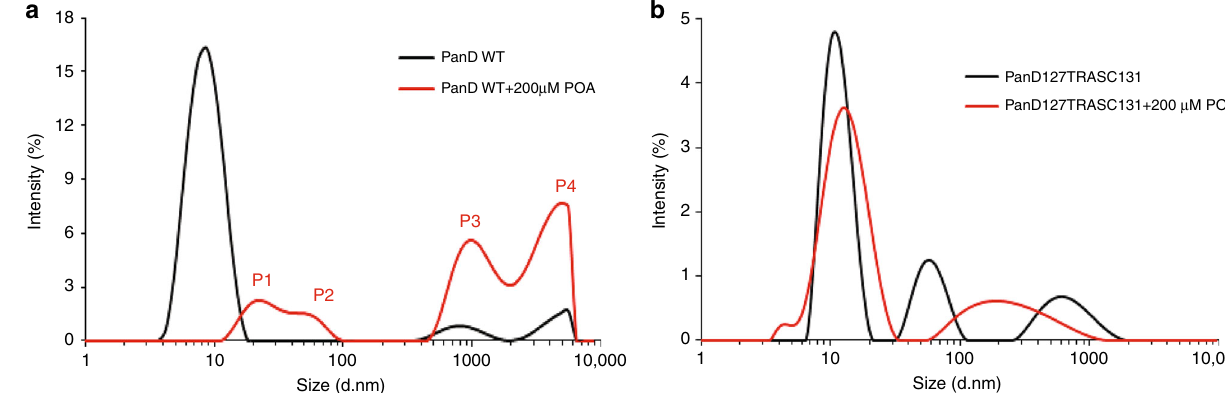
Fig. 5 Effect of POA on PanD WT and resistant mutant, non-POA binding PanD 127TRASC131 as determined by dynamic light scattering. a The distribution of the intensity of dynamic light scattering by PanD WT without drug (black) and PanD WT with 200 µ M POA (red) as a function of particle diameter ( d in nm) shows that PanD WT transforms into higher oligomers (P1 – 4) upon addition of POA with calculated hydrodynamic diameters of 21.04 ± 7.22, 55.04 ± 6.35, 955.4 ± 106.9, and 4801 ± 1134 nm, respectively. The estimated intensities of peaks 1 – 4 were 11%, 8%, 38%, and 43%, respectively. b In contrast, the PanD 127TRASC131 mutant retained its prominent peak at around 11.5 nm in the presence (red) of 200 μ M POA (drug-free control: black). Experiments were repeated three times yielding the same results. The results from a representative experiment are shown. These data show that POA causes oligomer formation of wild-type PanD but not of a POA-resistant mutant version of the protein. These results suggest that the drug does not cause protein aggregation per se. Source data are provided as a Source Data fi (Supplementary Table 1) were column puri fi ed and cloned into designated vectors using Gibson assembly. In vitro protein expression was carried out following the manufacturer ’ s instructions (NEB, E6800s). Brie fl y, 300ng of each column puri fi ed plasmid (Supplementary Table 1) was mixed with PURExpress solution A and B (10 and 7.5 µL, respectively), 0.5µL of RNaseOUT TM RNase inhibitors (Thermo), and